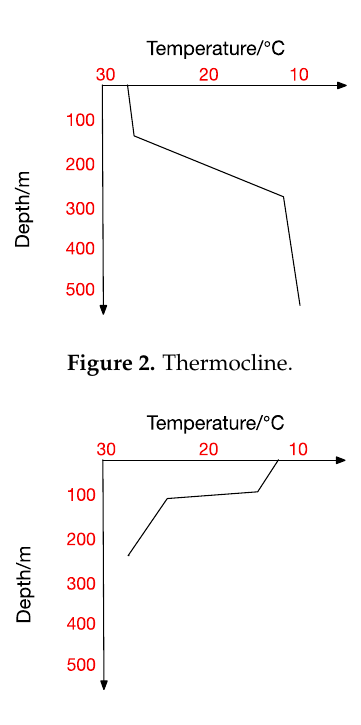
Figure 3. Inverse Thermocline.